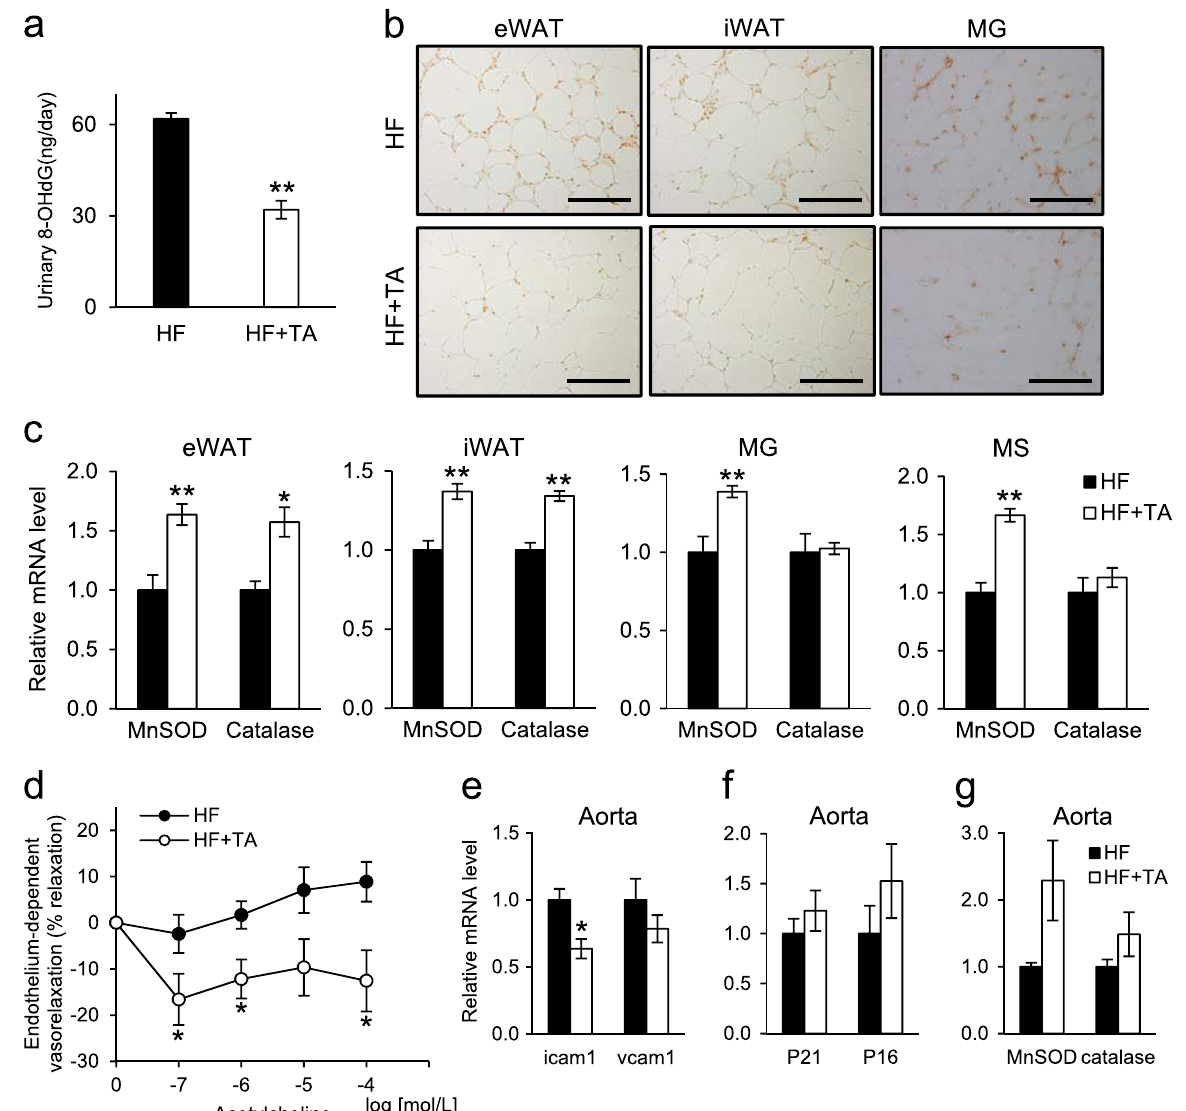
Fig. 4 Effect of TA-1887 on urinary excretion and tissue expression of 8-OHdG, expression of antioxidative enzymes and vascular function in db/db mice fed a high-fat diet. a Urinary excretion of 8-OHdG in db/db mice fed a high-fat (HF) diet and treated for 4 months as indicated, as measured by ELISA ( n = 5). b Immunohistochemistry with an 8-OHdG antibody of representative eWAT, iWAT and MG samples of mice treated 4 months as indicated. Scale bars: 200 μ m (eWAT, iWAT), 100 μ m (MG). c levels of mRNAs encoding the antioxidative enzymes MnSOD and catalase in eWAT, iWAT, MG and MS after 4 months of treatment ( n = 5 – 9). d Endothelium-dependent vasorelaxation in response to acetylcholine in aorta after 4 months of treatment ( n = 5 – 9). e Expression of transcripts associated with vascular in fl ammation in aorta of mice treated as indicated for 4 months ( n = 5 – 9). f Expression of senescence marker transcripts in aorta after 4 months of indicated treatment ( n = 5 – 9). g Expression of transcripts encoding antioxidative enzymes in aorta after 4 months of indicated treatment ( n = 5 – 9). Values shown are means ± SEM. * p < 0.05 and ** p < 0.01 versus